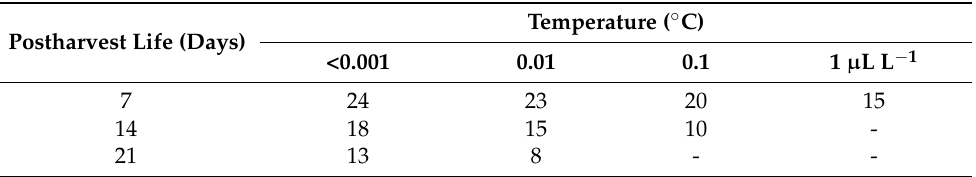
Table 2. The storage temperature of green bean that allows specific postharvest life periods in the presence of specific ethylene